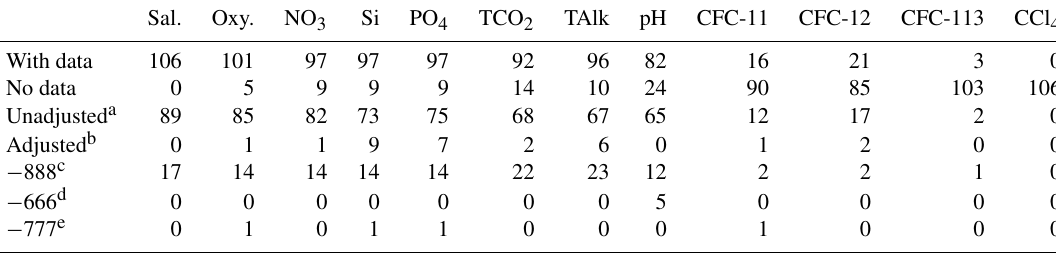
a The data are included in the data product file as they are, with a secondary QC flag of 1. b The adjusted data are included in the data product file with a secondary QC flag of 1. c Data appear of good quality but have not been subjected to full secondary QC. They are included in the data product with a secondary QC flag of 0. d Data are of uncertain quality and suspended until full secondary QC has been carried out; they are excluded from the data product. e Data are of poor quality and excluded from the data